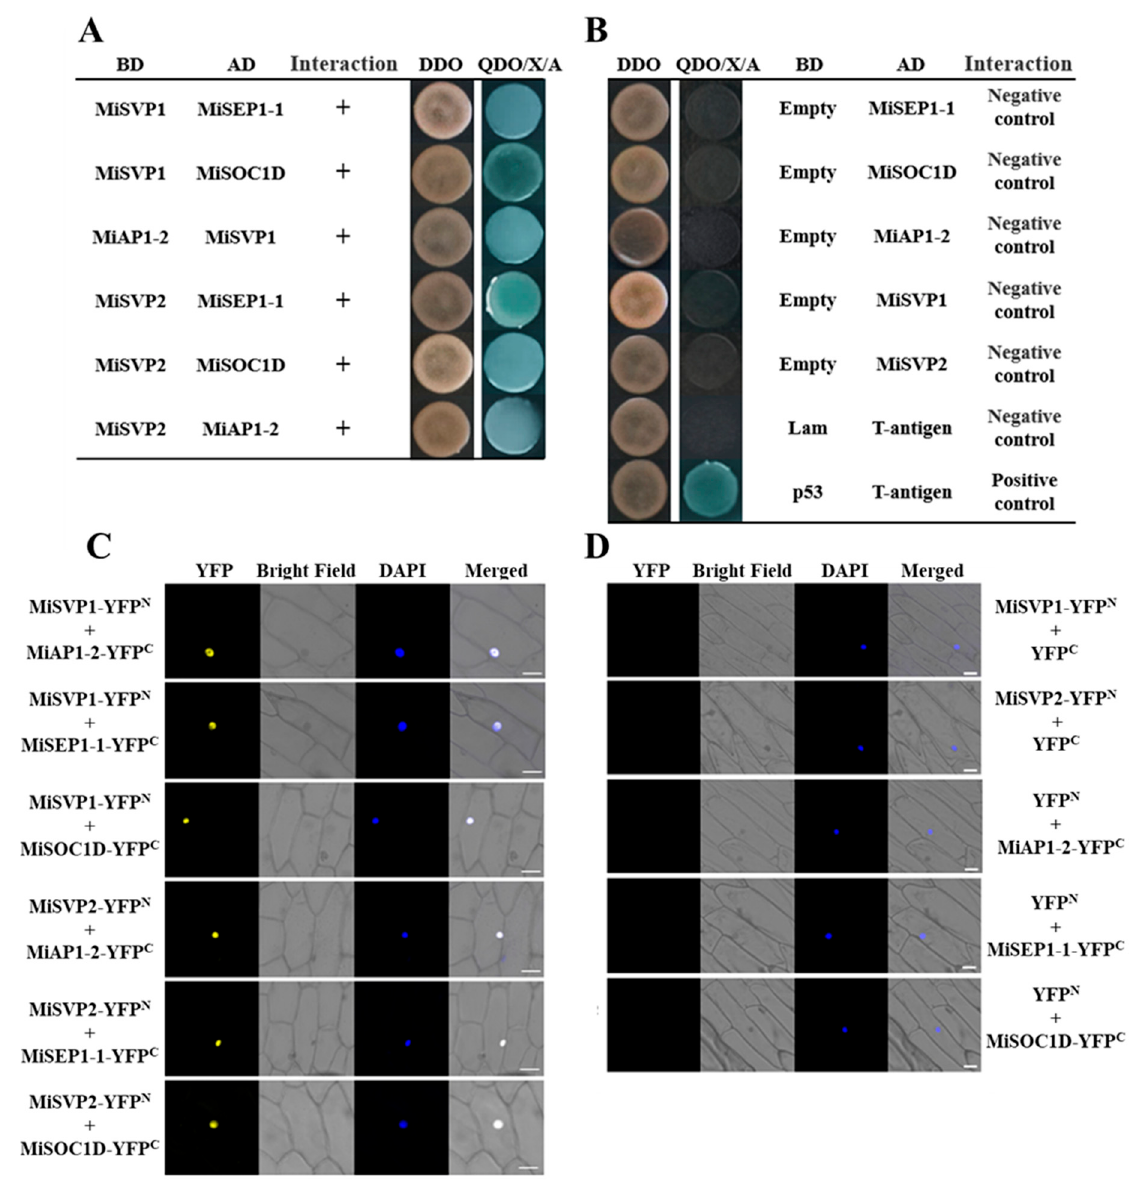
Figure 7. Identification of MiSVP1 and MiSVP2 interacting proteins. ( A ) Point-to-point verification of MiSVP1and MiSVP2 with candidate proteins. ( B ) The self-activation verification of candidate proteins. ( C ) BiFC assays of MiSVP1and MiSVP2 with candidate proteins. ( D ) BiFC assays of MiSVPs and candidate proteins with empty vector. YFP: Signaling of a YFP-fused protein by fluorescence microscopy; DAPI: staining shows cell nucleus; Merged: superimposed YFP, DAPI, and bright-field images. Bars = 20 μ m.